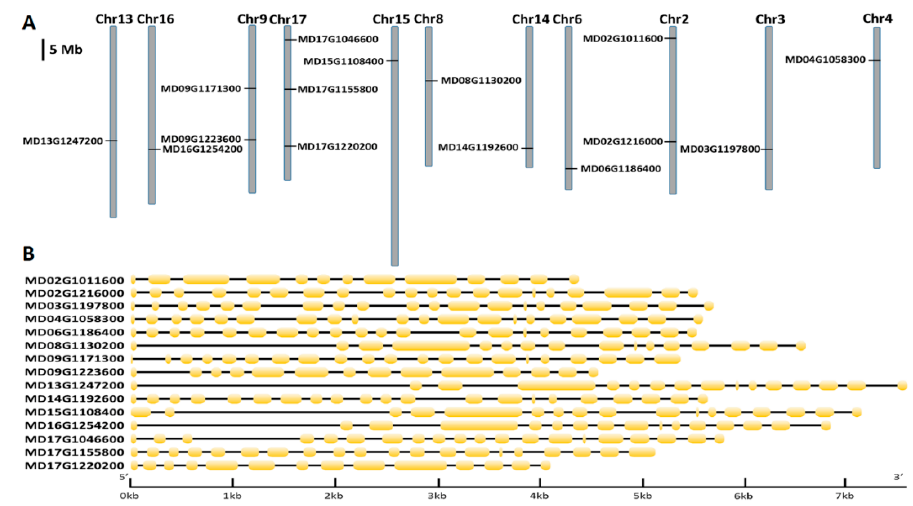
Figure 1. Genes encoding P 3A -Type ATPase genes in apple genome. ( A ) Chromosomal localization of apple P 3A -Type ATPase. ( B ) Exon / intron organization of apple P 3A -Type ATPase. Yellow boxes indicate exons; black line indicates introns.